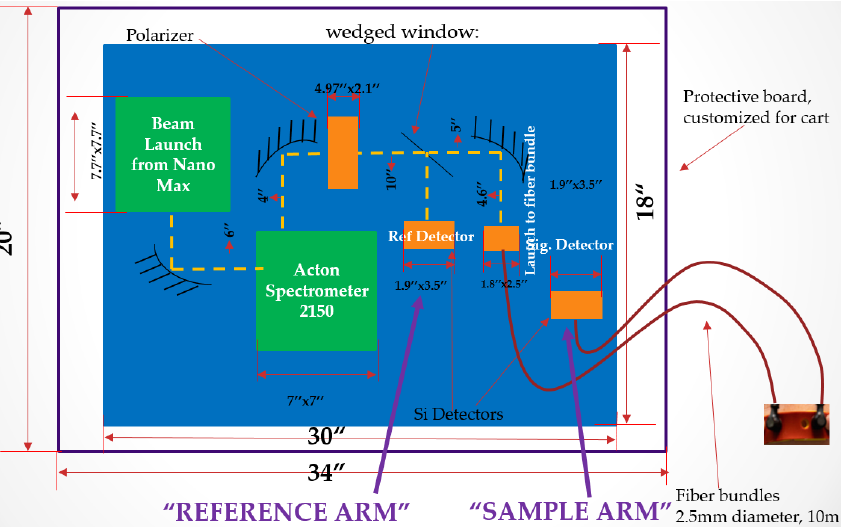
Figure 23. Detailed optical block diagram of optical system hardware (cart middle layer).